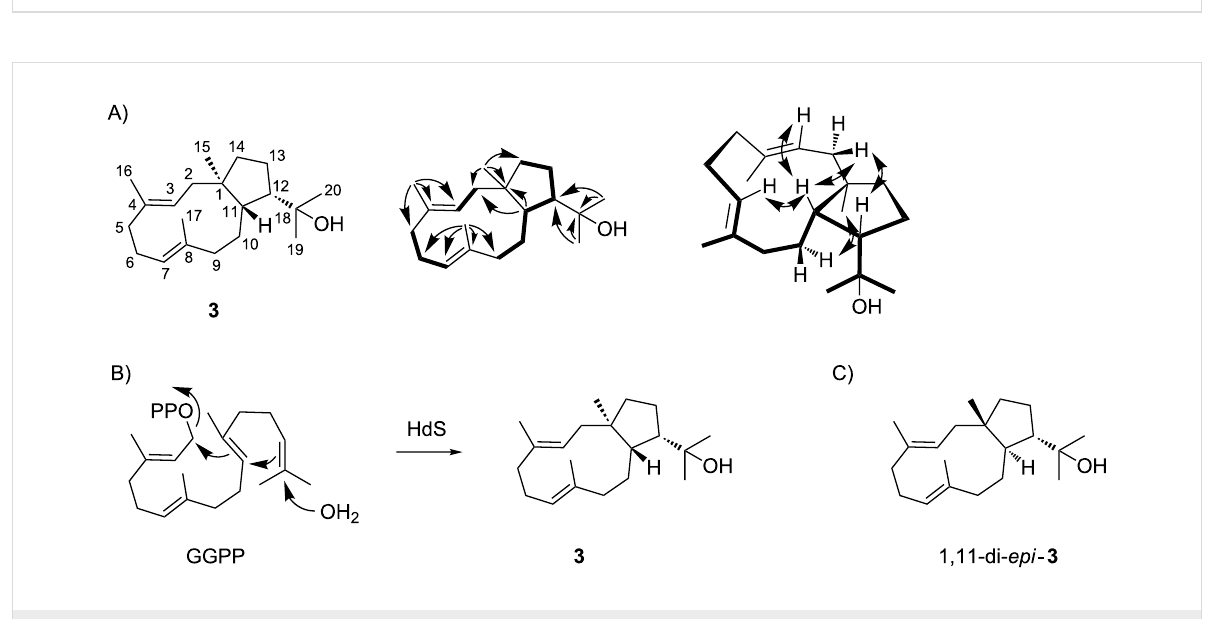
Scheme 2: Product obtained from the diterpene synthase from C. pinensis . (A) Structure of (1 R ,3 E ,7 E ,11 S ,12 S )-18-hydroxydolabella-3,7-diene ( 3 ), contiguous 1 H, 1 H-COSY spin systems (bold), and diagnostic HMBC and NOESY correlations (single and double headed arrows). (B) Cyclisation mechanism for the conversion of GGPP into 3 by HdS. (C) Structure of the known stereoisomer 1,11-di- epi - 3